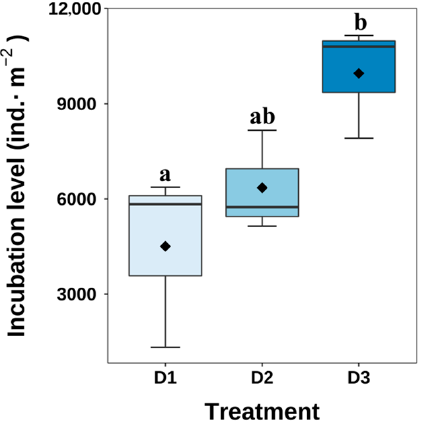
Figure 6. Incubation levels (ind. · m − 2 ) of ovigerous P. clarkii in the three different treatments after 25 days. The diamond symbol inside the box represents the mean. Different lowercase letters indicate significant differences ( p < 0.05) among shelter treatments.